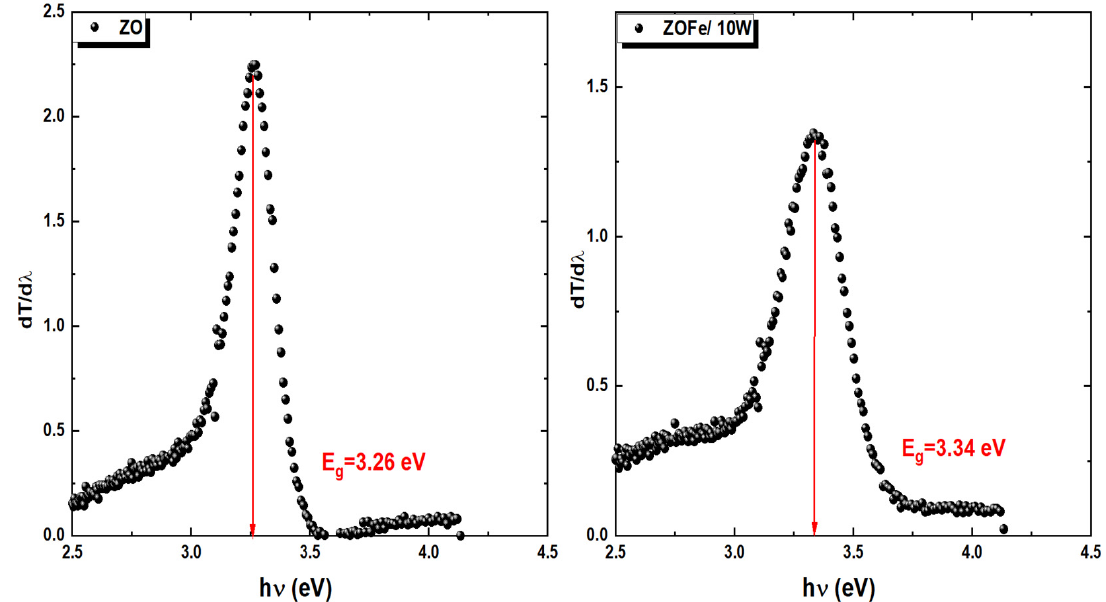
Figure 10. dT/d λ vs. photon energy for the undoped and undoped and ZOFe/10 W thin films.